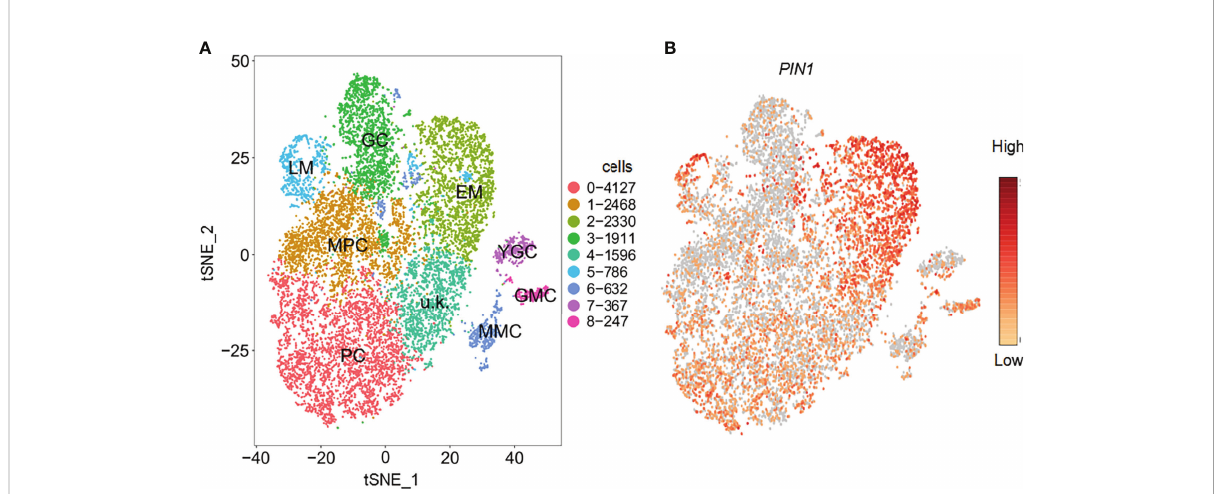
FIGURE 1 Identi fi cation of cell types with representative marker genes. (A) Distribution of cell types on tSNE plot; corresponding cell types are annotated on the plot. (B) Feature plot showing the expression pattern of PIN1. PC, pavement cell; GMC, guard mother cell; GC, guard cell; MMC, meristemoid mother cell; EM, early stage meristemoid; LM, late stage meristemoid; YGC, young guard cell; MPC, mesophyll cell; u.k.,